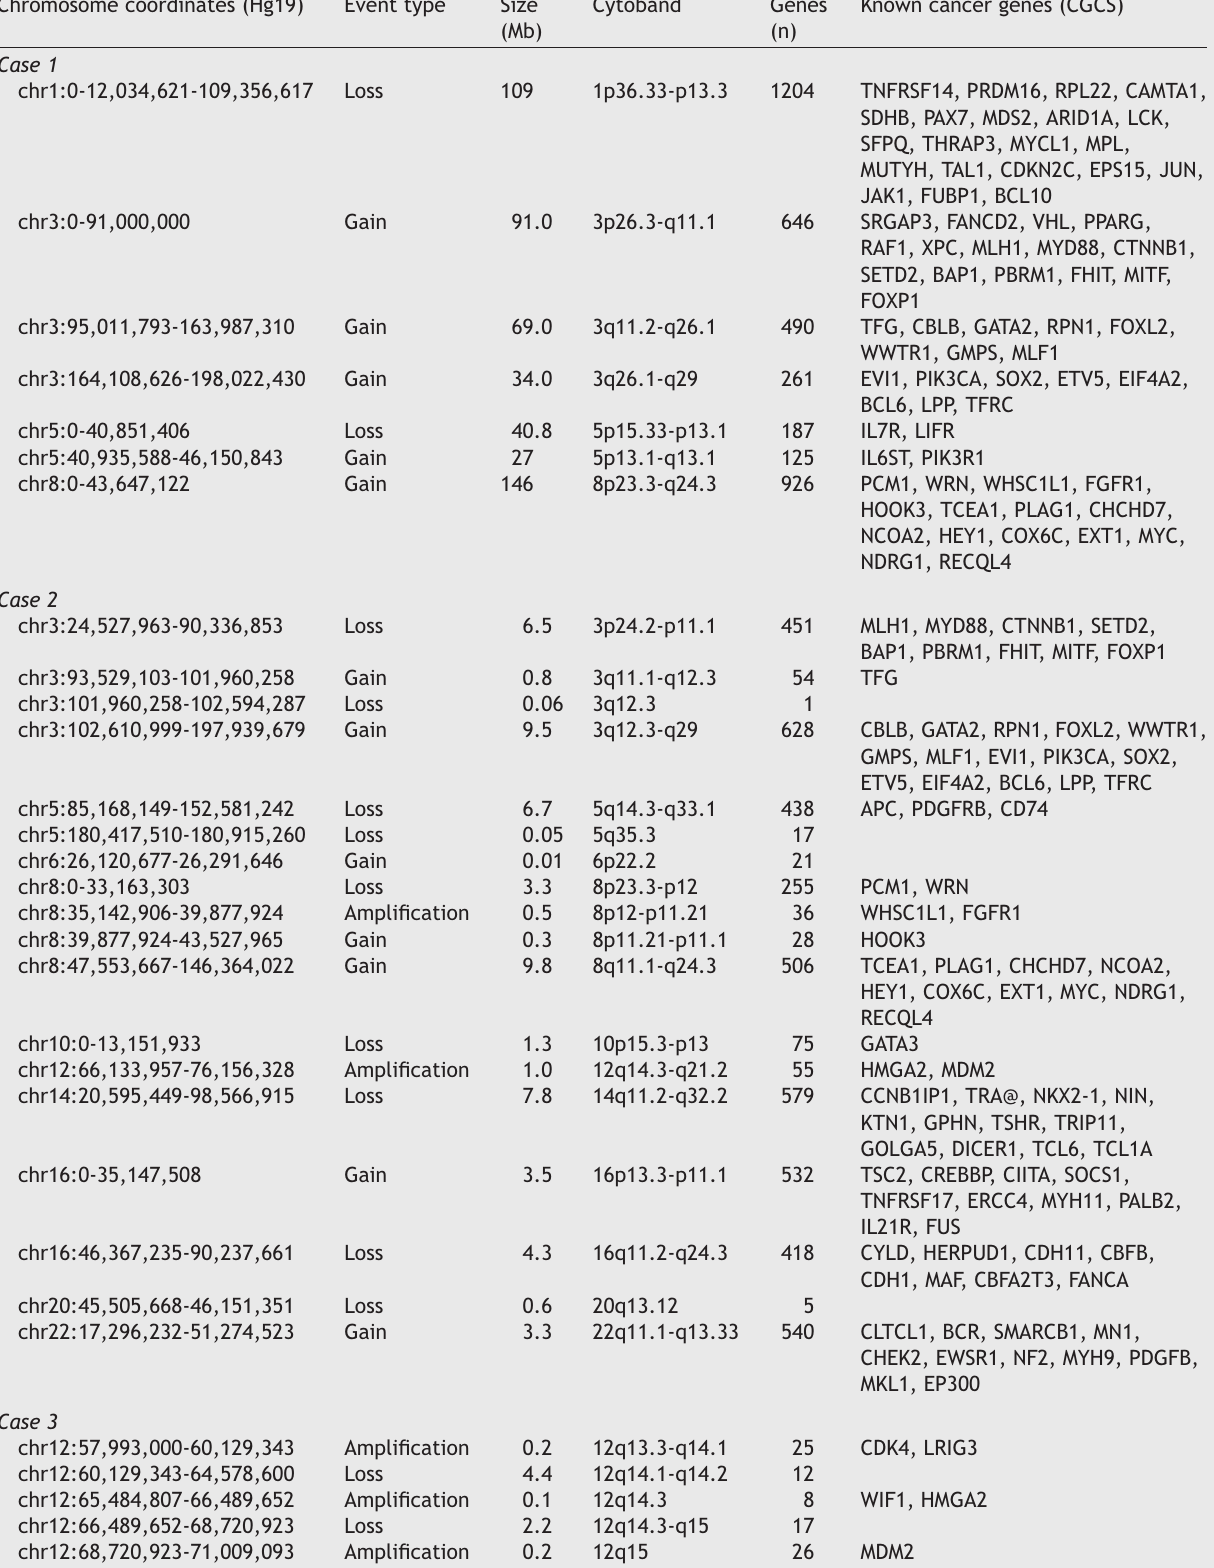
Table 1 Somatic copy number alterations detected by array-CGH in three cases of CXPA from RPA. Chromosome coordinates